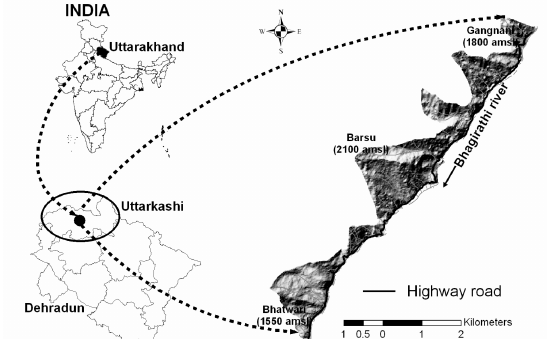
Figure 1. Location map of study area along the National Highway corridor of NH-108 between Bhatwari and Gangnani